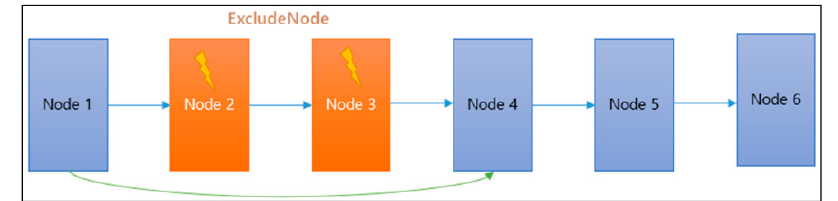
Figure 27. Waypoint node that removes the dangerous area.